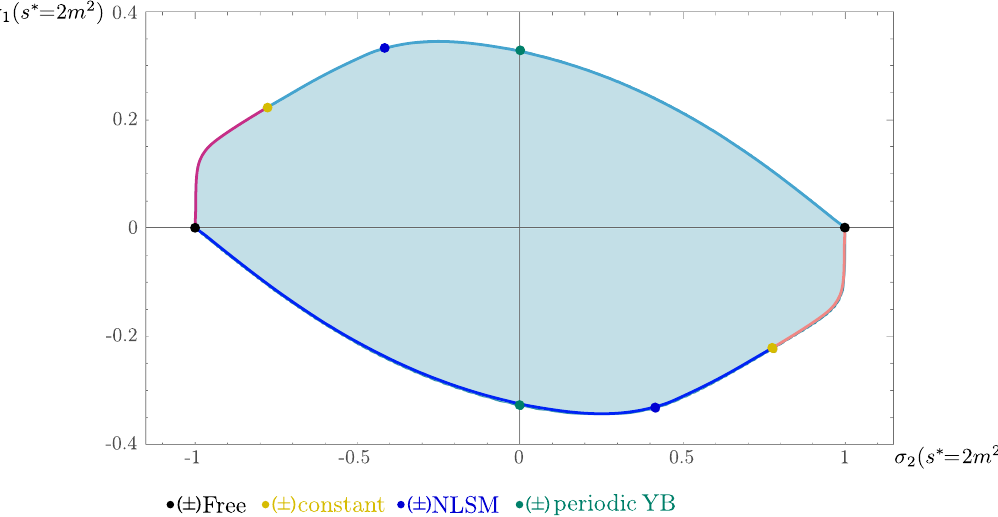
Figure 7 . Allowed space of S-matrices in the plane (cid:27) 1 ( s (cid:3) = 2) vs (cid:27) 2 ( s (cid:3) = 2). The coloring at its boundary matches the convention in table 1. We have also marked the points corresponding to known integrable S-matrices and the constant solution in